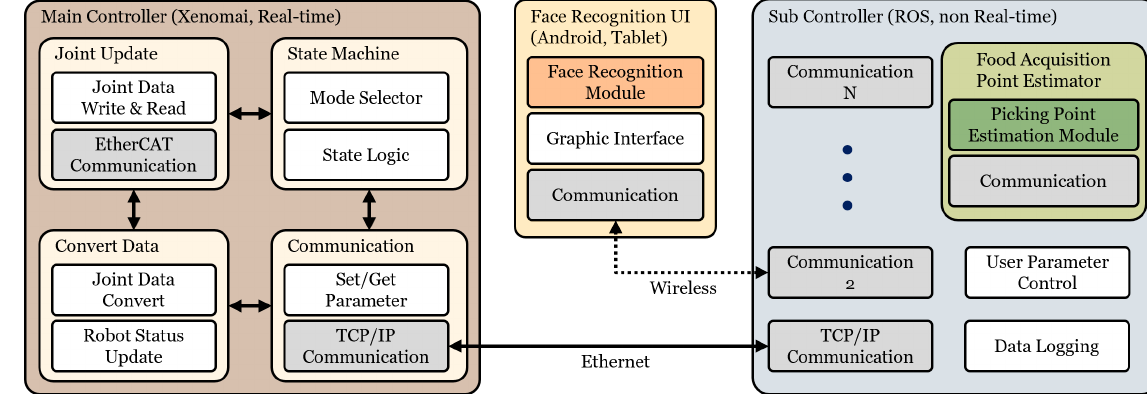
Figure 4. Control system diagram.